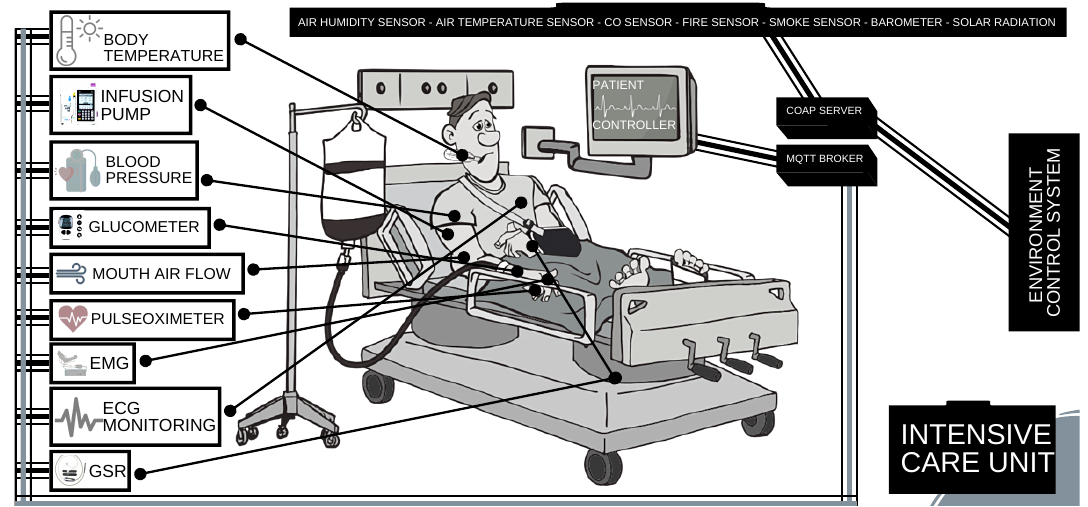
Figure 4. IoT ICU use